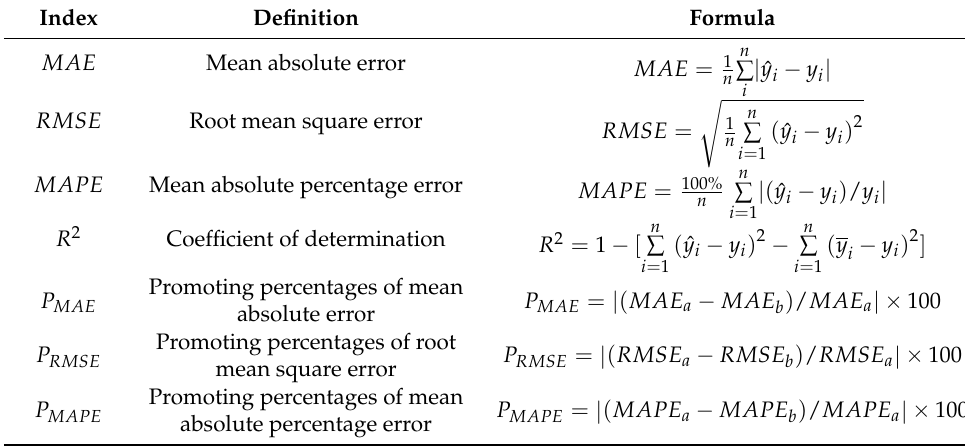
Table 1. Seven evaluation indicators and corresponding calculation formulas.